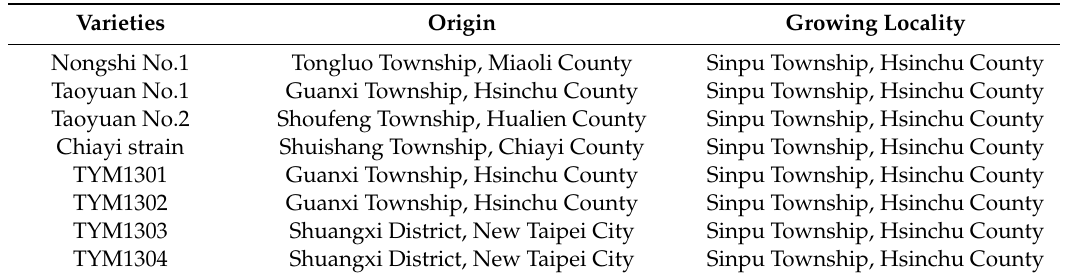
Table 1. The study of collections of taxa currently assigned to Hsian-tsao.